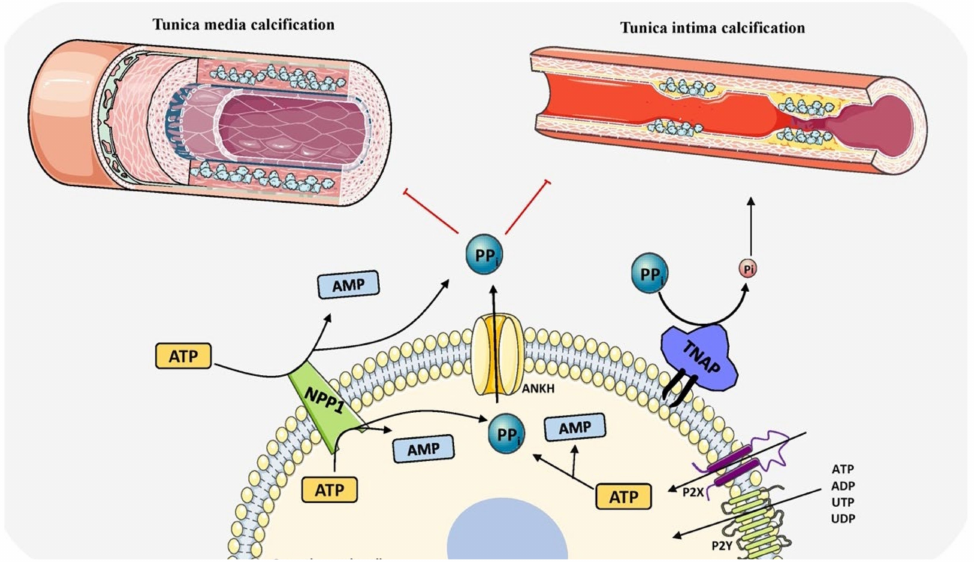
Figure 4. Schematic representation of the role of TNAP in vascular calcification by determining PP i /P i ratio and balancing induction and inhibition of mineralization. The components in this figure were modified from Servier Medical Art, licensed under a Creative Common Attribution 3.0 Generic License (http://smart.servier.com, accessed on 1 August